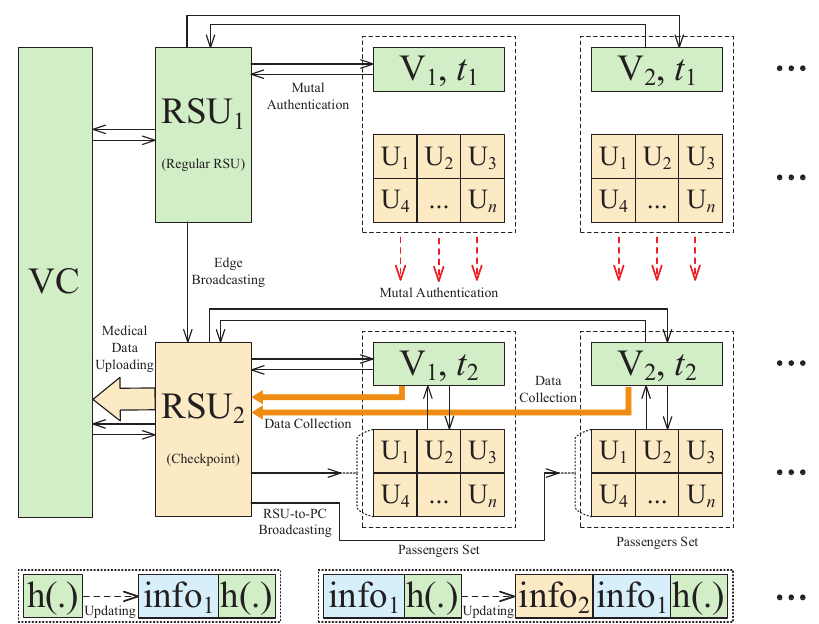
Figure 2. Vehicular ad hoc networks (VANET) Authentication and Healthcare Monitoring